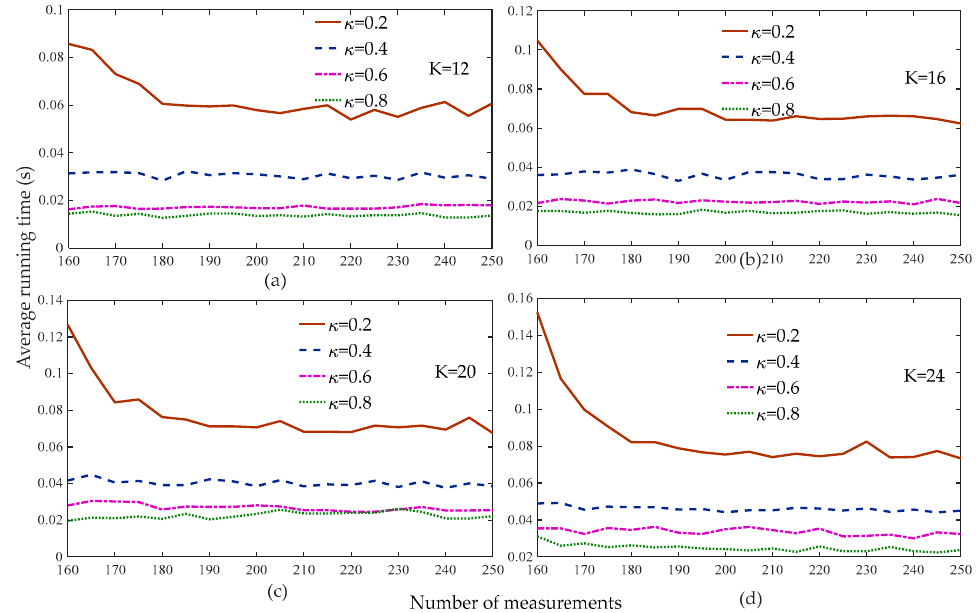
Figure 4. Average running time of the proposed method with different weak selection thresholds ( ( n = 256, K = 12,16,20,24, κ = 0.2,0.4,0.6,0.8, m = 160 : 5 : 250, Gaussian